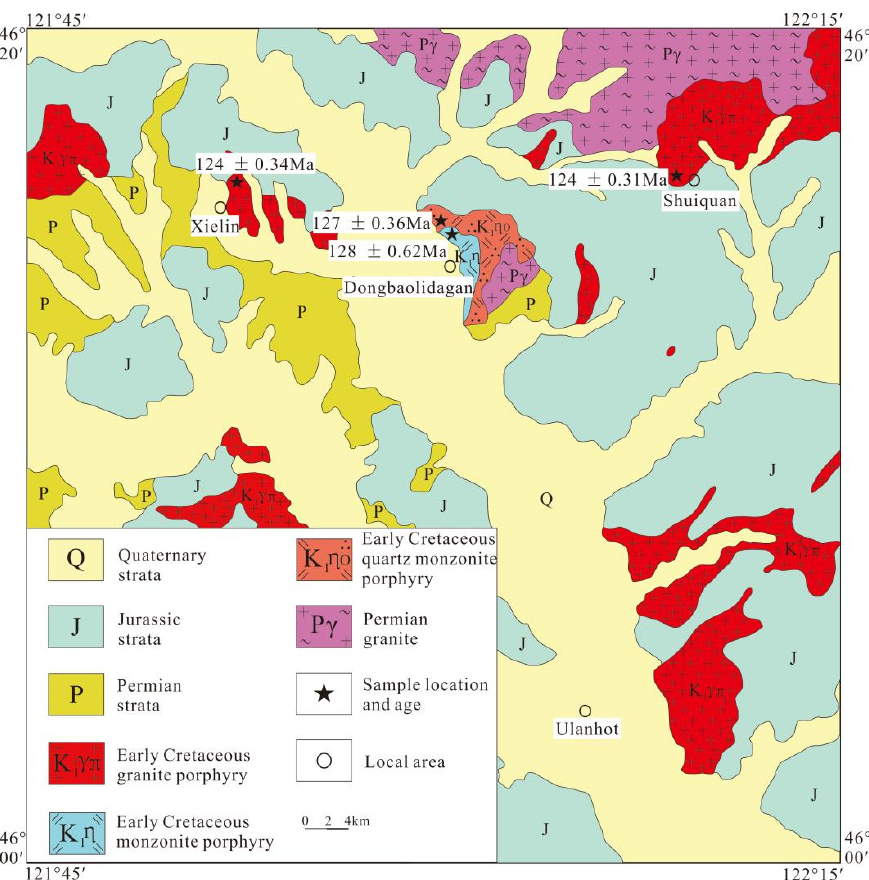
Figure 2. Simplified 1:200,000 regional geological survey map and sample locations of the Ulanhot area.